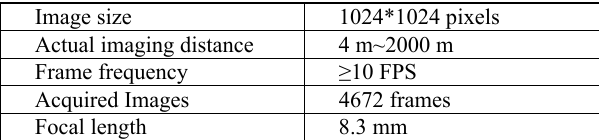
Table 4.Change of ground points after adjustment